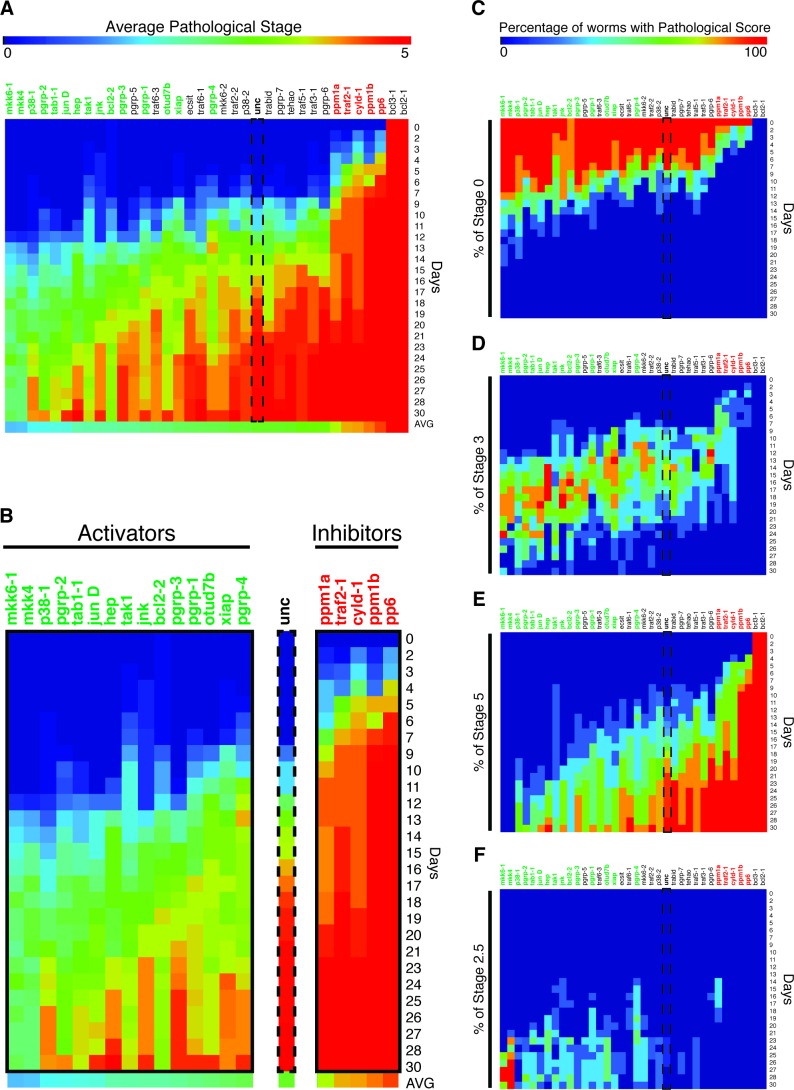
Heatmap depicting results of an RNAi screen for mediators of pathological progression following bacterial infection in planaria.(A) Heatmap depicting average pathological scores for each RNAi treatment following 2e8 CFU/ml Pseudomonas infection (n = 5–12 worms per condition). Days versus average pathological score over time are aligned along the y-, and x- axes, respectively. Unc control sample is indicated by a dashed box. RNAi-targeted genes that significantly reduce or enhance pathological progression are highlighted in green and red, respectively (2-way ANOVA p<0.05). (B) Focus on RNAi of genes that result in a significant reduction (activators) or enhancement (inhibitors) or pathological progression. (C–F) Heatmaps depicting the percentage of worms exhibiting pathological stage (C) 0, (D) 3, (E) 5, and (F) 2.5 for each RNAi treatment following Pseudomonas infection. Ordering and significance based on average pathological score over time are maintained for reference.DOI:
http://dx.doi.org/10.7554/eLife.16793.01410.7554/eLife.16793.015Figure 5—source data 1.Homologous innate immune and inflammatory genes from RNAi screen.DOI:
http://dx.doi.org/10.7554/eLife.16793.01510.7554/eLife.16793.016Figure 5—source data 2.Pathological scores of worms in RNAi screen for mediators of infection induced tissue degeneration.